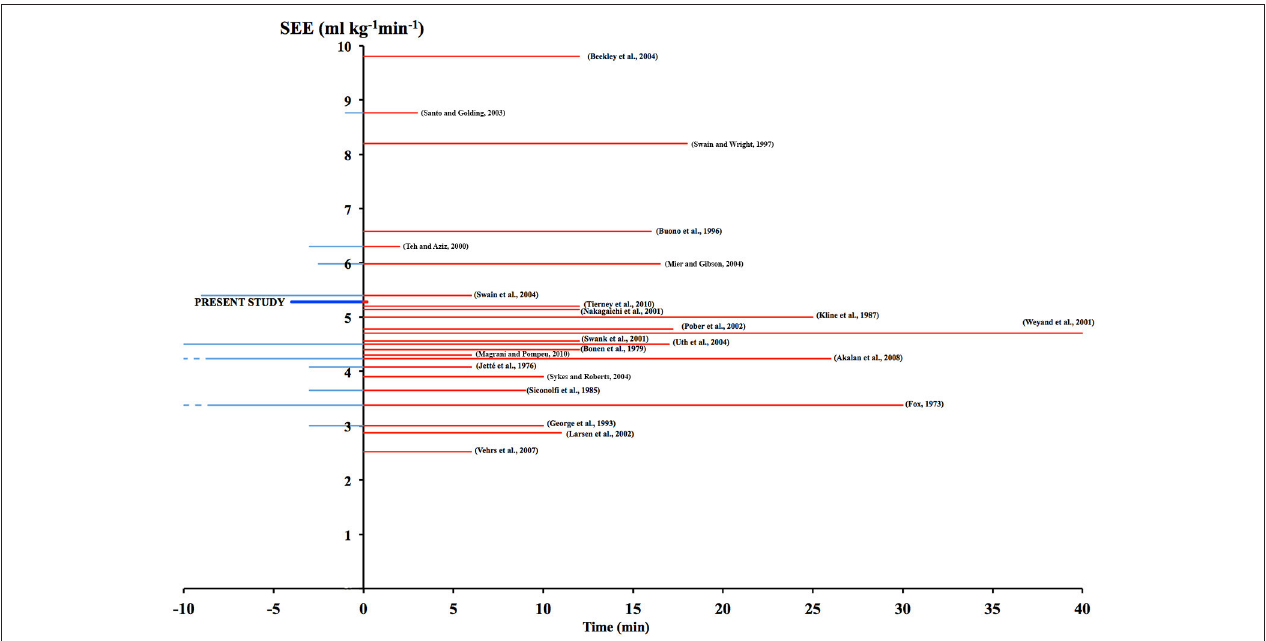
FIGURE 6 | Accuracy of the ˙ VO 2peak prediction, as SEE (ml . kg − 1. min − 1 ), is presented in relation to average protocol duration ( t , min) clustered in exercise (red positive bars) and rest (blue negative bars) time. Present data is shown as thick lines. SEE of other predictive equations on submaximal protocols are shown for comparison with their bibliographic reference. A more detailed discussion about the quoted investigations can be found in Sartor et al. (2013)